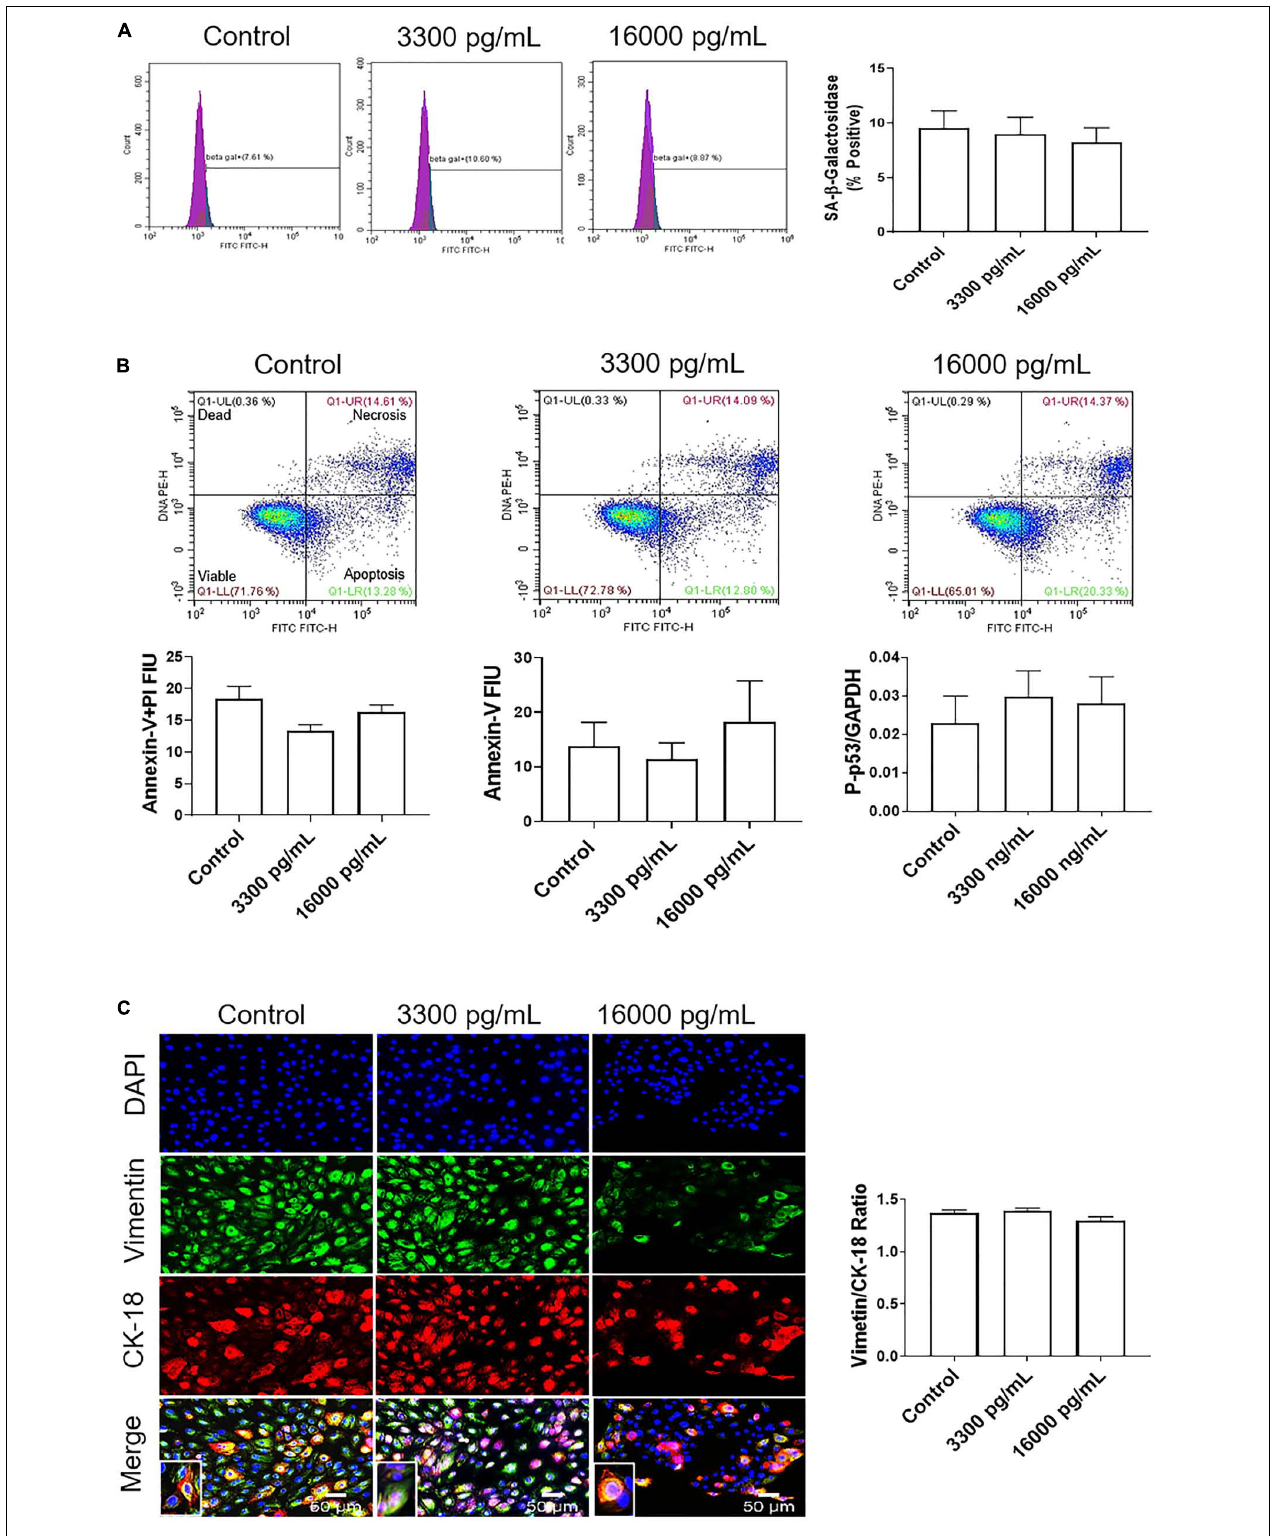
FIGURE 4 | IL-6 concentration reported in the amniotic fluid of infection associated pPROM does not induce cellular aging, cell death, or cellular transitions in AECs. (A) Flow cytometry analysis of IL-6 induced senescence in AECs. Physiologic and pathologic concentrations of IL-6 did not increase the population